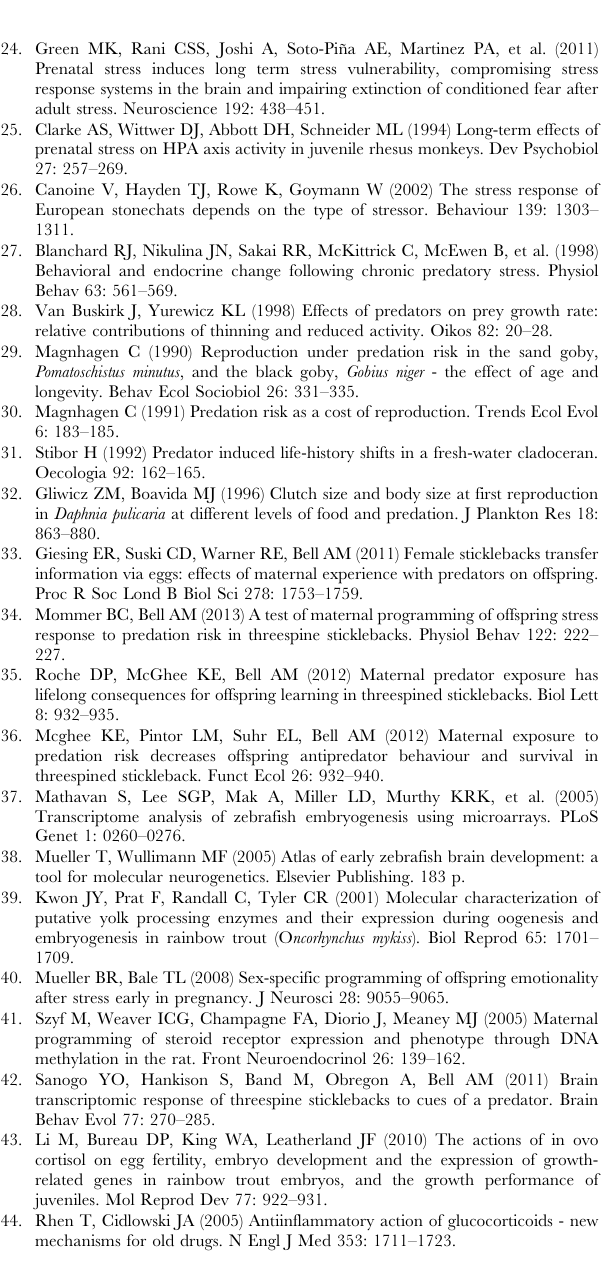
Table S2 The most overrepresented biological annotations from the list of genes differentially expressed between 3dpf stickleback embryos exposed to maternal stress and embryos of control mothers as measured via RNA-seq. Genes were mapped to their associated biological process (BP_FAT), cellular component (CC_FAT), molecular function (MF_FAT), and KEGG pathways using Mus musculus gene annotations and genome background within the DAVID Functional Annotation Tool (v6.7). Only terms with FDR , 0.05 and $ 2 genes were included. Table S3 GO terms and KEGG pathways obtained using Danio rerio gene annotations and genome background within the DAVID Functional Annotation Tool (v6.7). Only terms with FDR , 0.05 and $ 2 genes were